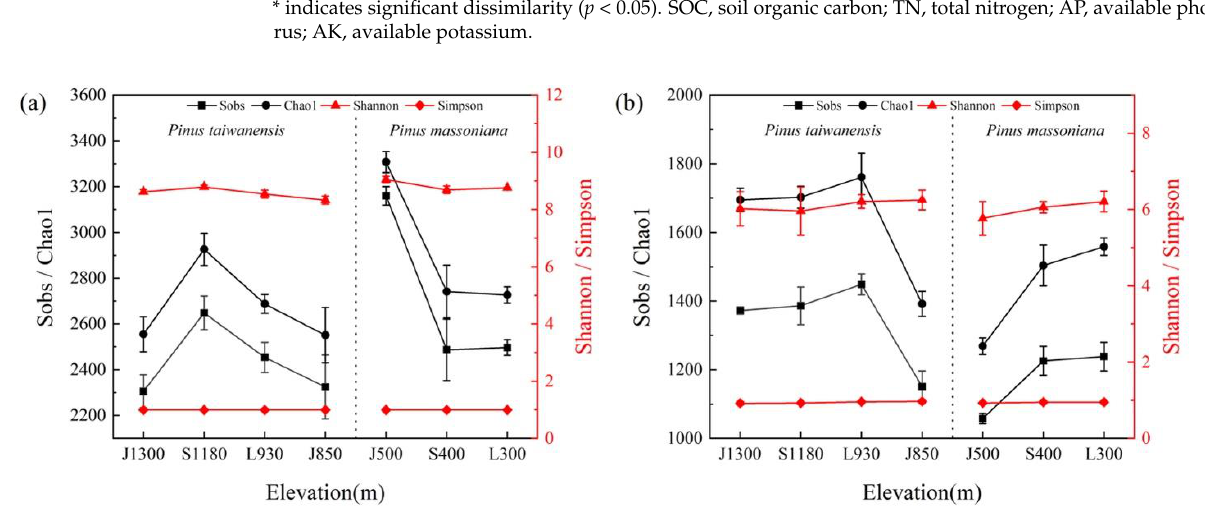
Figure 2. Alpha diversity of bacterial ( a ) and fungal ( b ) diversity in Pinus taiwanensi and Pinus massoniana forests soils with the elevations.